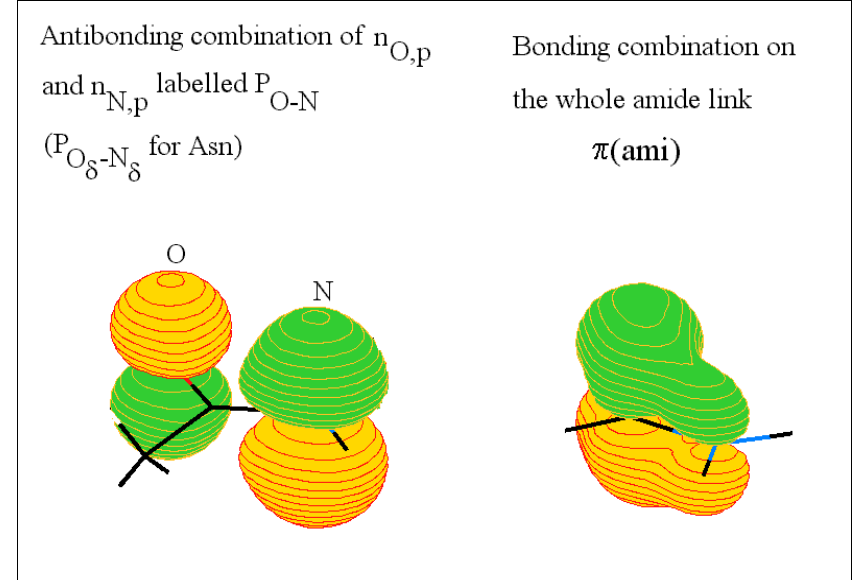
Figure 4 : π -Type MO on the amide link.